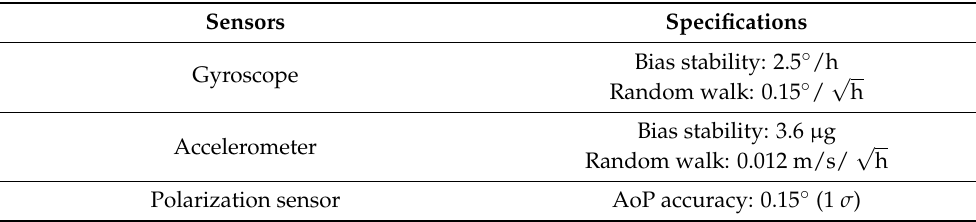
Table 3. The PAHRS